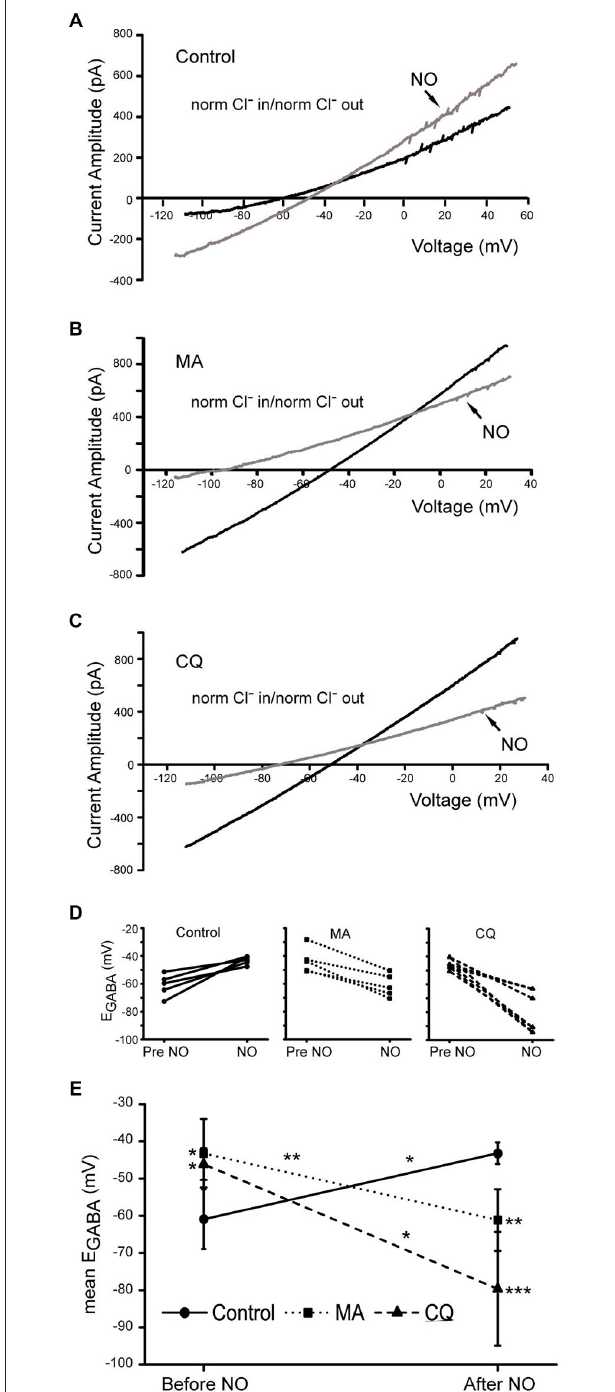
FIGURE 9 | In normal Cl − , increasing compartmental pH promotes NO-dependent Cl − efflux from the cytosol . GABA-gated currents in response to voltage ramps were recorded in normal internal and external solutions. (A) , A recording from a control cell is shown with about a 10 mV positive shift in reversal potential in response to NO. (B,C) , GABA-gated currents in cells containing MA or CQ, respectively. In both cases the reversal potentials of the currents before NO are more positive than the calculated